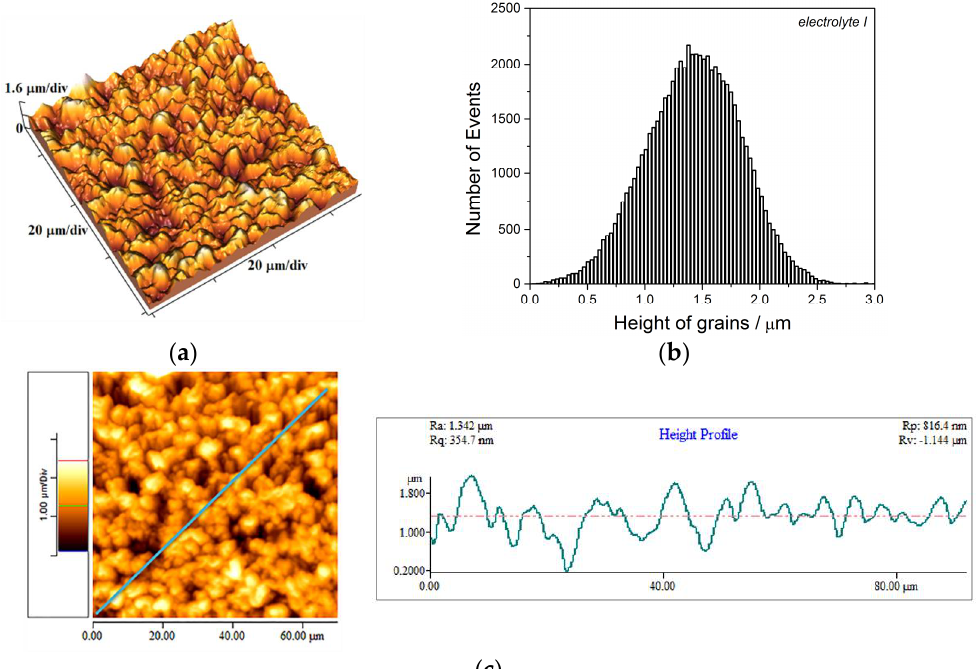
Figure 8. The AFM analysis of 40 µm thick Cu coating obtained by electrodeposition at a current density of 50 mA cm −2 on the Si(111) substrate from electrolyte I : ( a ) the surface topography, ( b ) the histogram and ( c ) line section analysis (X-axis: distance line; Y-axis: height profile). Scan size: (70 × 70) µm 2 .